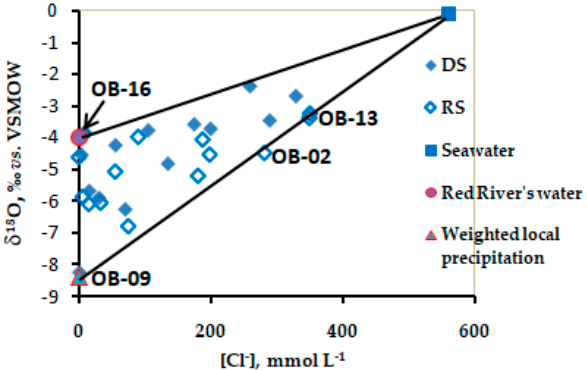
Figure 7. The δ 18 O vs. molar [Cl − ] relationship for groundwater in Holocene aquifer in the study region representing a mixture of three end-members: local precipitation, Red River’s water and seawater (see Figure 1 for OB-09, OB-16, OB-02 and OB-13 locations).